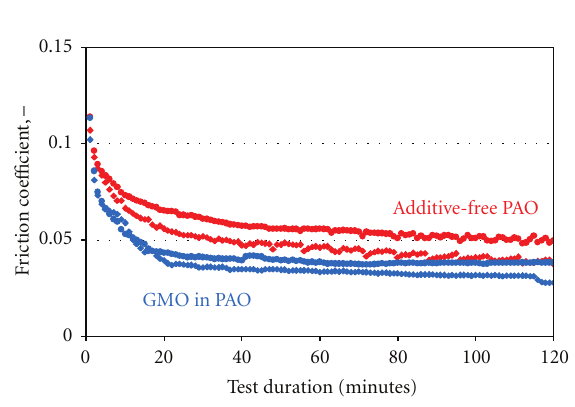
Figure 3: Friction trace for squalane.